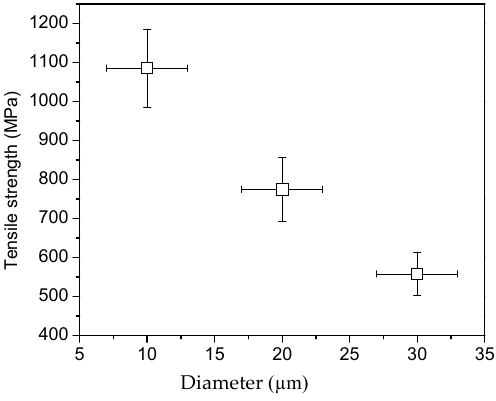
Figure 1. Tensile Strength of different diameter EDA/MBDGA cross ‐ linked MWCNT threads.